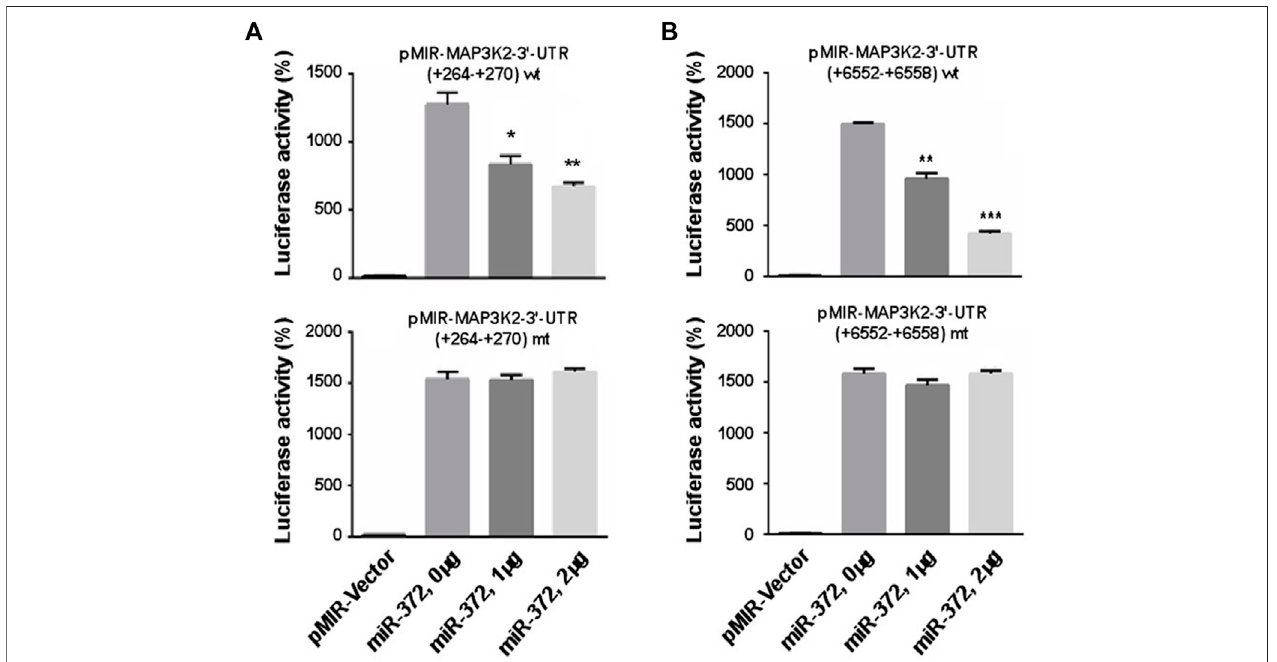
FIGURE 6 | miR-372-3p modulated the expression of MAP3K2 by targeting its 3 ′ -UTR in SW480 colon cancer cells. (A,B) Relative luciferase activities of pMIR- MAP3K2 3 ′ -UTR wild type (wt) and mutants (mt) were detected in pMIR-Vector and miR-372-3p mimics (0, 1, and 2 µg) groups. * p < 0.05, ** p < 0.01, *** p < 0.001, vs. vector group (Mann Whitney test). Three biological replicates were